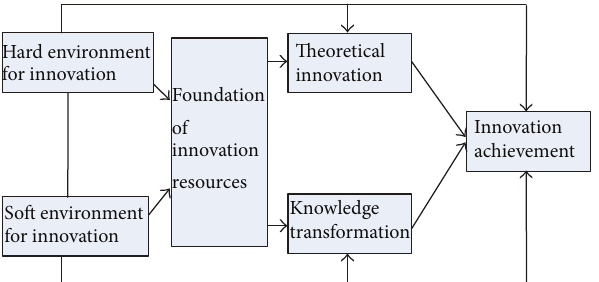
Figure 2: The basic elements of the regional collaborative innova-